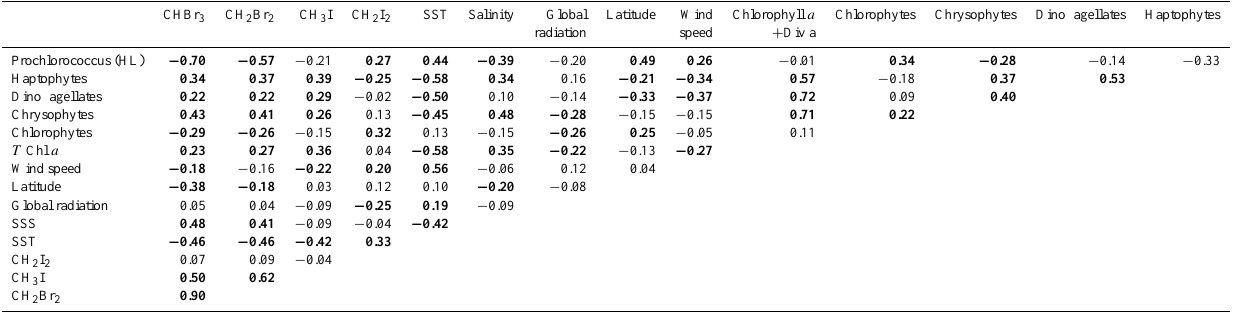
Table 2. Spearman’s rank correlation coefficients r s of halocarbons with different physical parameters and phytoplankton species measured in surface water. Numbers printed in bold are regarded as significant with p <0.05. CHBr 3 CH 2 Br 2 CH 3 I CH 2 I 2 SST Salinity Global Latitude Wind Chlorophyll a Chlorophytes Chrysophytes Dinoflagellates Haptophytes radiation speed + Diva Prochlorococcus(HL) − 0.70 − 0.57 −